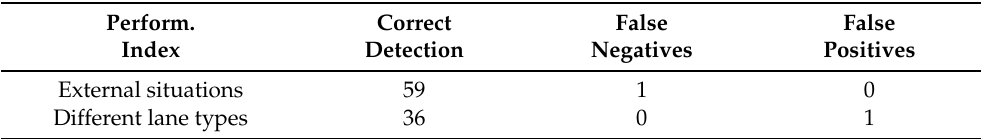
Table 3. Test results from real road.